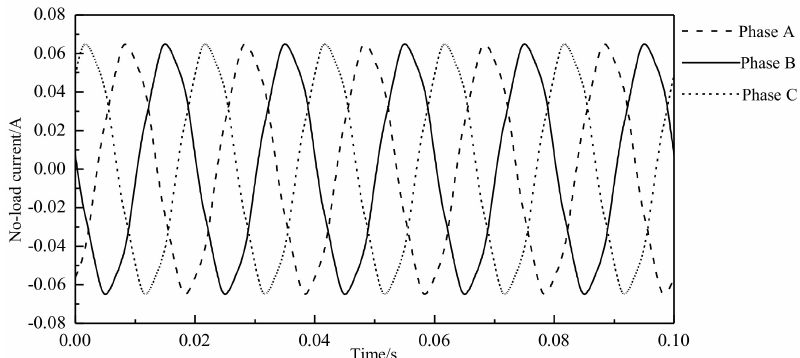
Figure 4. No-load current waveform at rated voltage.